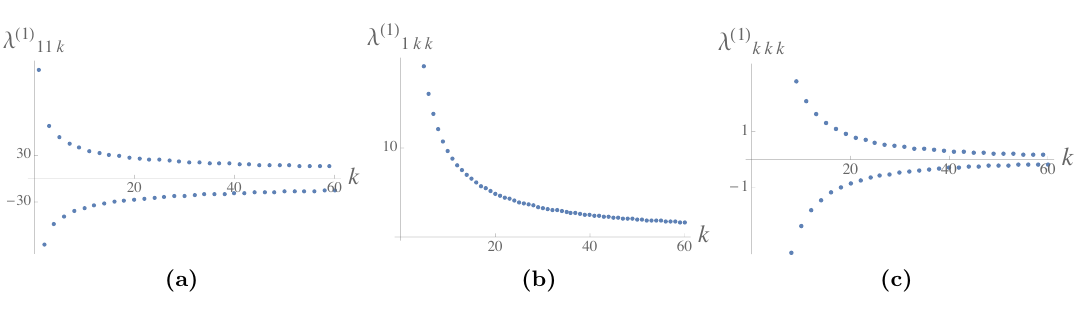
at large q for some special nmk